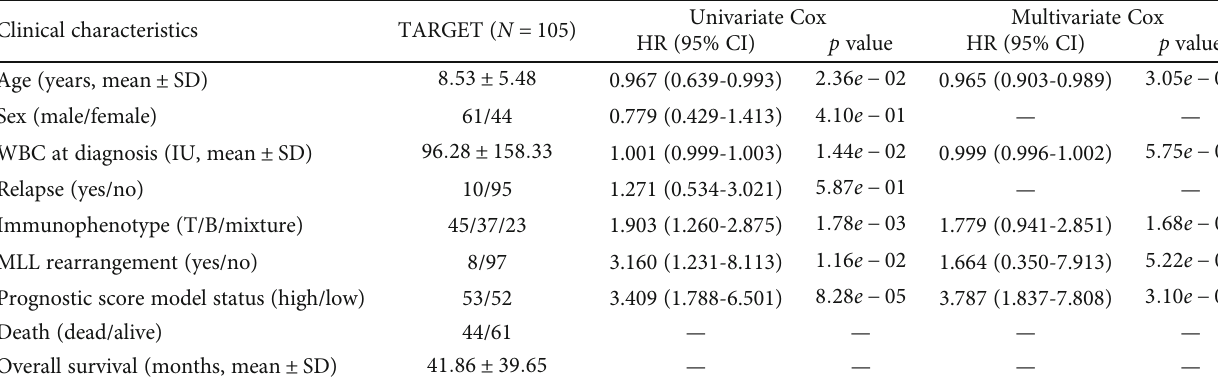
Table 3: Univariate and multivariate Cox regression analyses of overall survival. Clinical